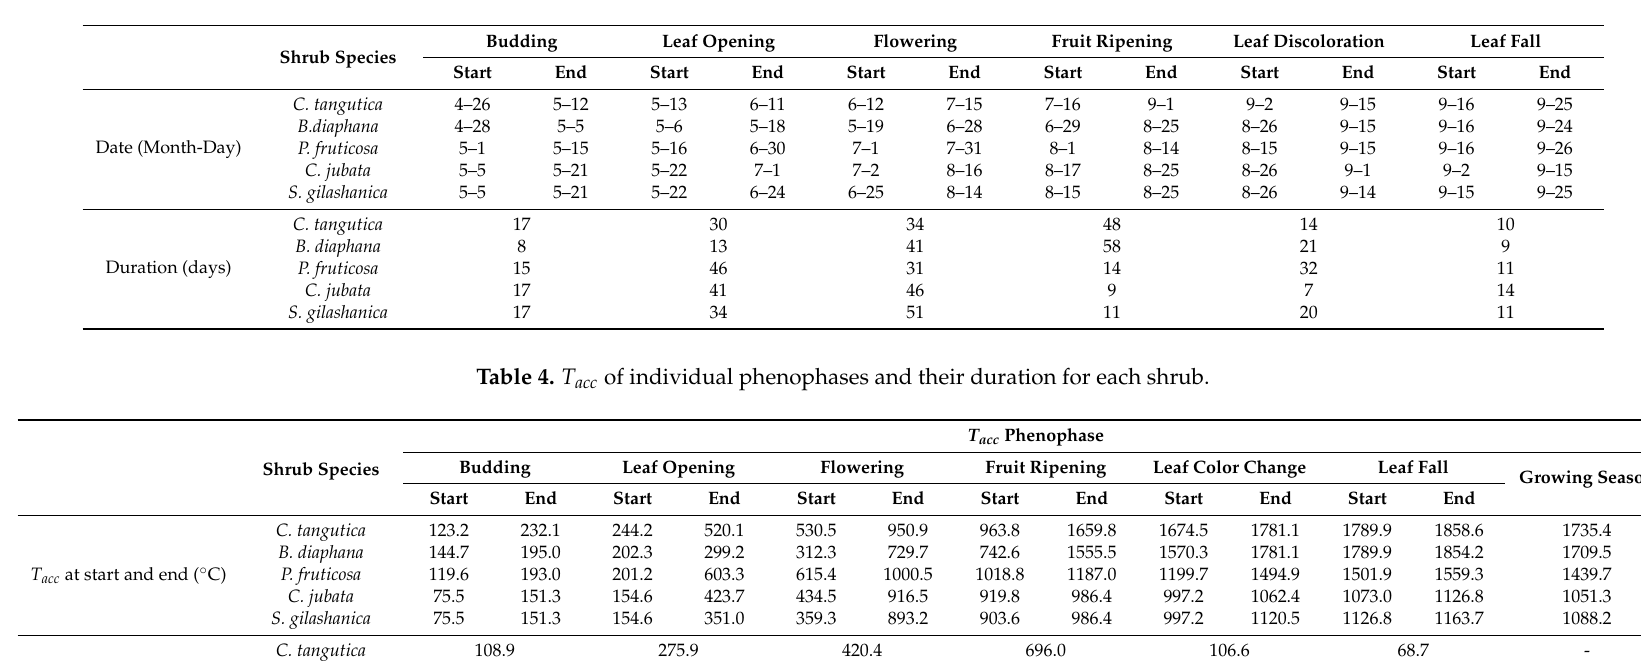
Table 3. Start and end dates of specific phenophases and their duration for five shrub species in 2015.